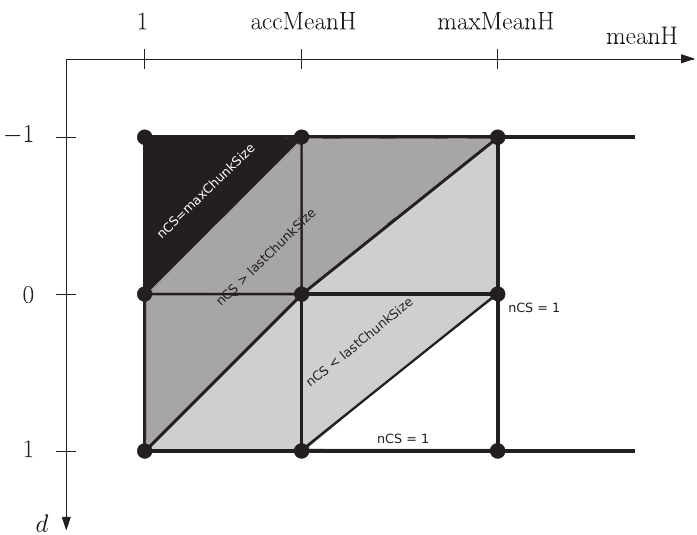
Fig 6. 2D representation that connects our function with the intuitive behavior described in Sect. 7.